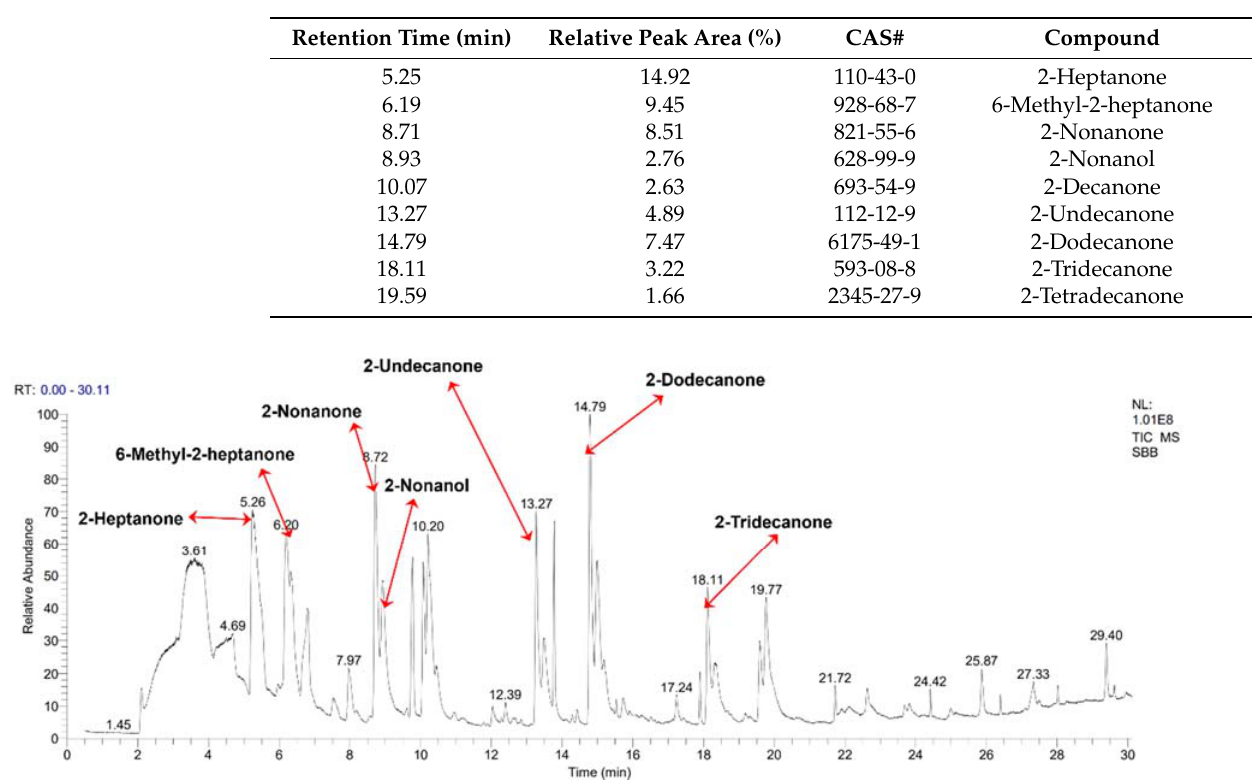
Figure 7. Gas chromatograph-mass spectrometer analysis of volatile organic compounds in Bacillus velezensis SBB.